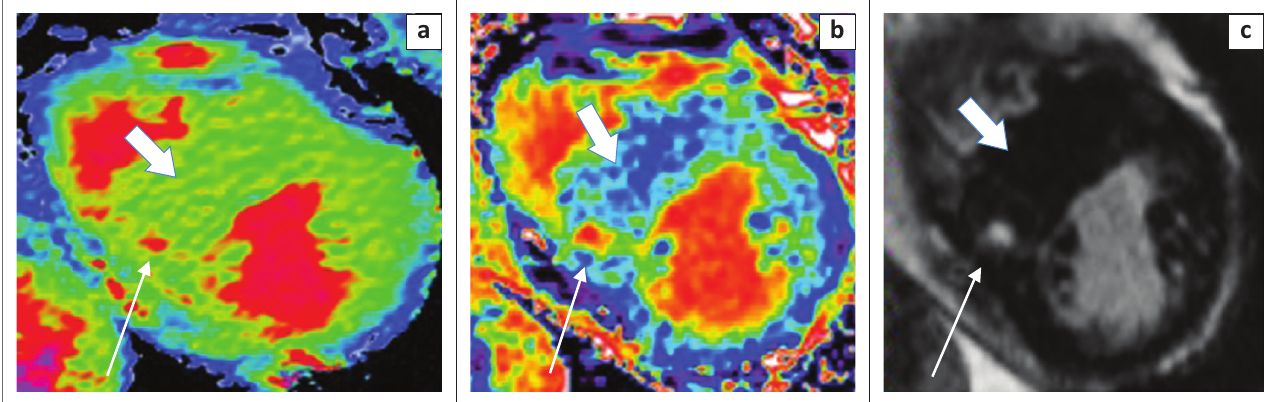
FIGURE 8: Native T1 map (a), ECV map (b) and LGE in mid SAX slice (c) in HCM. Note the inferior LV/RV insertion point fibrosis seen as high T1 and high ECV volume and LGE respectively. The LGE image sees the inferior RV insertion point LGE (long arrow) but misses the wider patchy fibrosis (short arrows) in the maximally hypertrophied septal segments which is easily appreciated in the native T1 and ECV